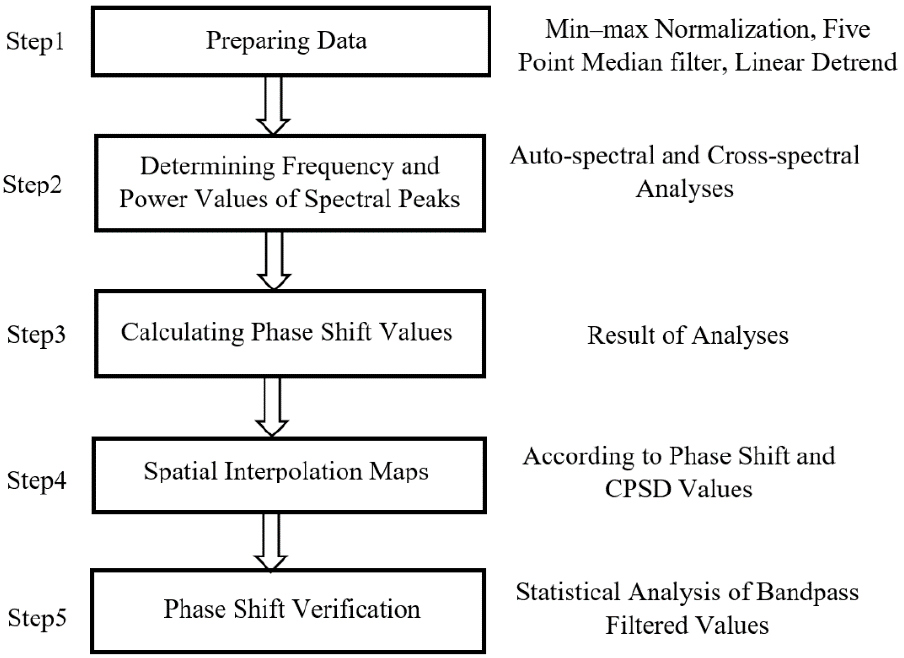
Figure 3. General flow chart for this study.